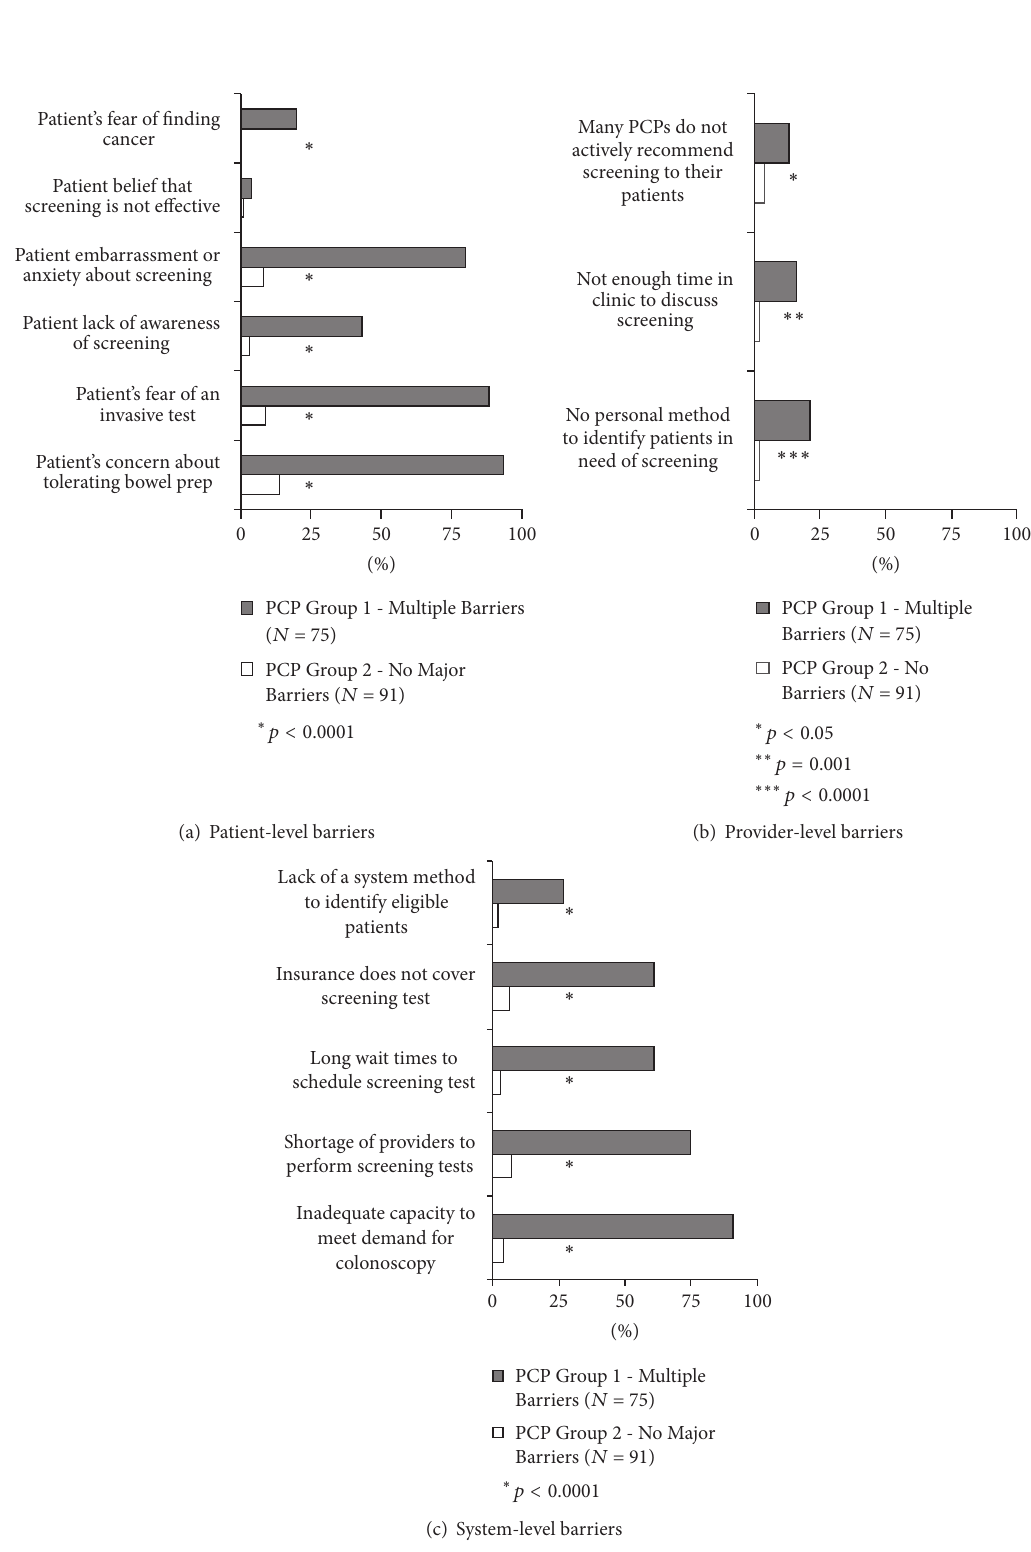
Figure 1: Distribution of survey responses across the two groups of providers for (a) perceived patient-level barriers, (b) perceived provider- level barriers, and (c) perceived system-level